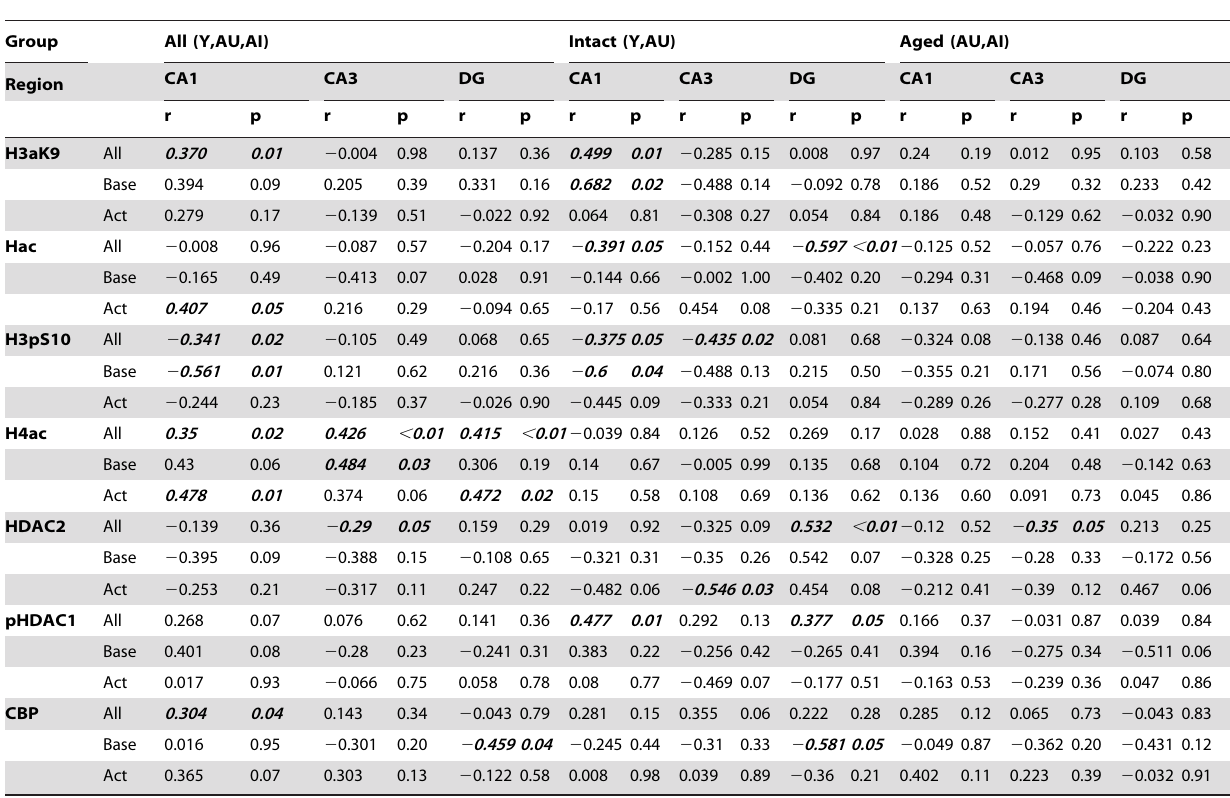
Table 2. Pearson r correlation coefficients and associated p-values for the learning index scores from initial behavioral characterization in relation to the chromatin modification quantification in collapsed groups: All (Y, AU and AI), cognitively Intact (Y and AU), and Aged (AU and AI). Significant correlations (p # 0.05) are bolded and italicized.